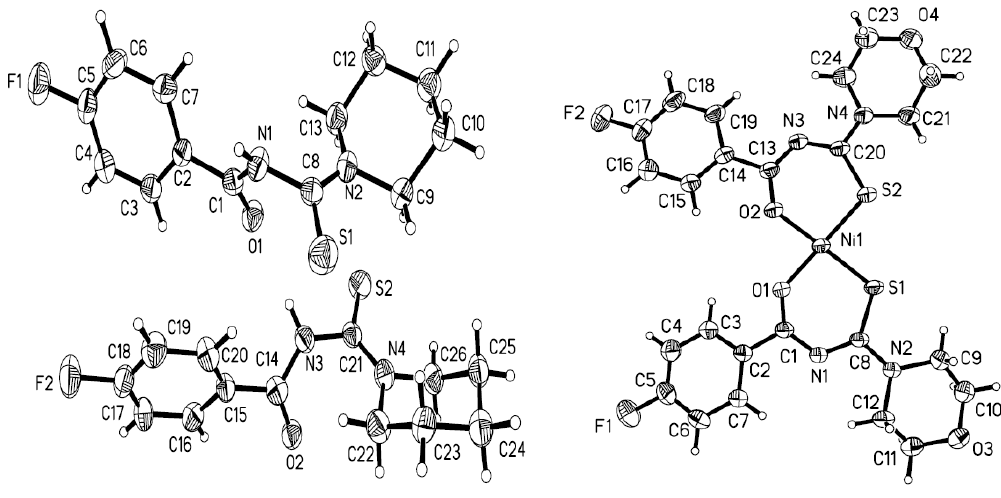
], with thermal ellipsoids drawn at 40% 2